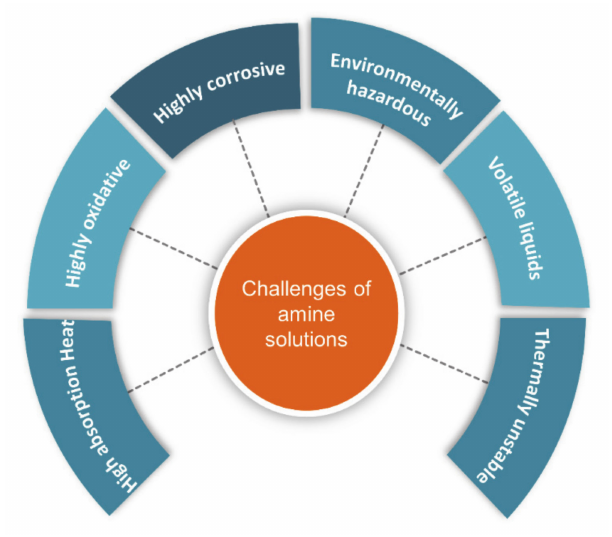
Figure 1. Major challenges of using amine solutions